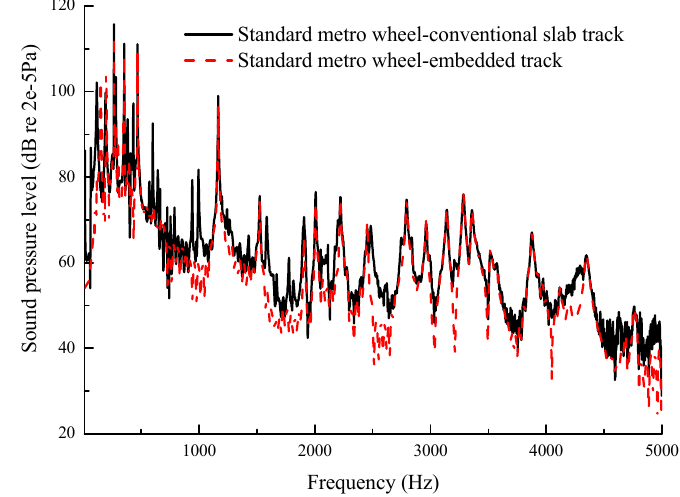
Figure 16. Total SPLs considering standard metro wheels coupled with the conventional slab track and embedded track (simulation results).